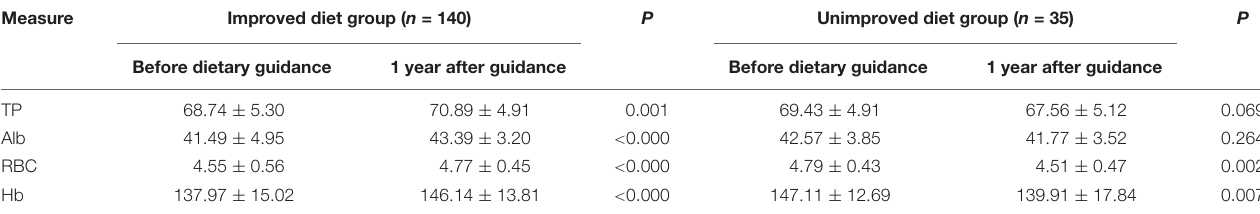
TABLE 5 | Comparison of nutritional status before and after guidance between the diet improvement group and the diet non-improvement group. Measure Improved diet group ( n = 140)